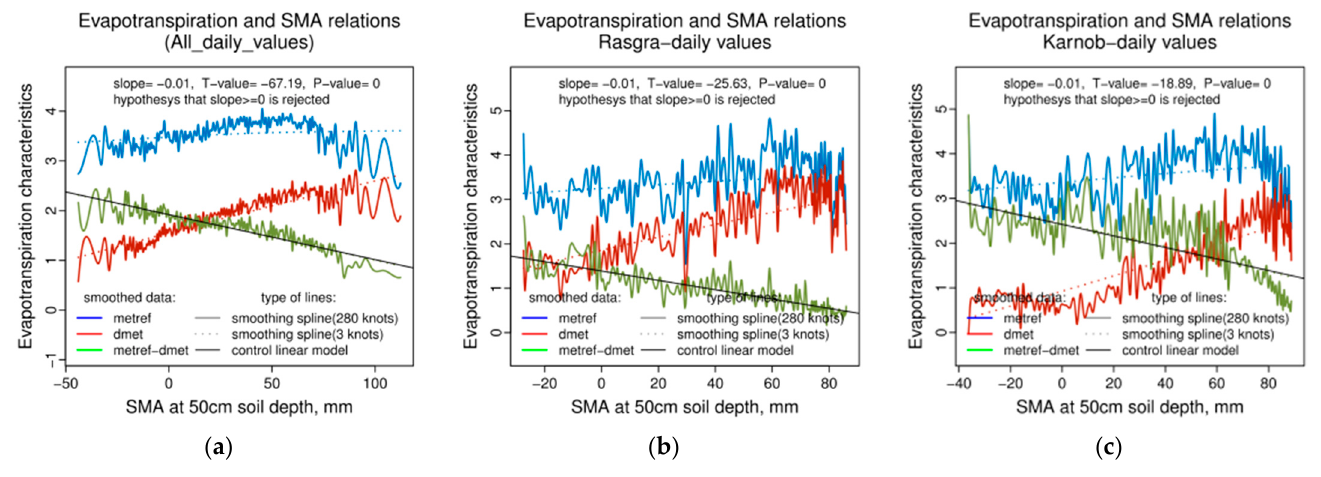
Figure 8. The complementary relationship between PE (METREF) and AE (DMET) values and the ED deficit (in the sense of the Bouchet hypothesis [45]) as the drought indicator for: ( a ) the entire Bulgarian landmass; ( b ) Rasgrad station in northeastern Bulgaria; ( c ) Karnobat station in southeastern Bulgaria. ( d ) Evapotranspiration deficit (green line) approximated using a linear regression model (black line). Mean daily values for May–October 2011–2021 were used for calculation.